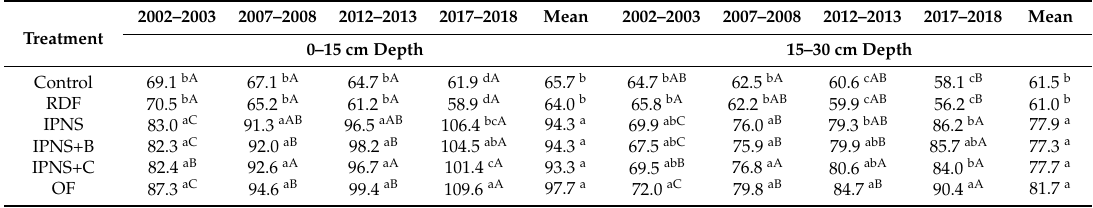
Table 7. Effects of different nutrient management options on the soil exchangeable K content (mg kg − 1 ) in at soil depths of 0–15 and 15–30 cm after 5 RWS cycle intervals.